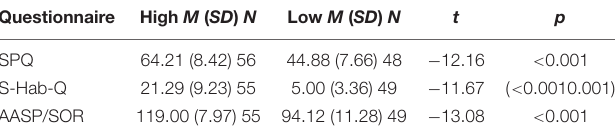
TABLE 2 | High and low scores of self-report sensory